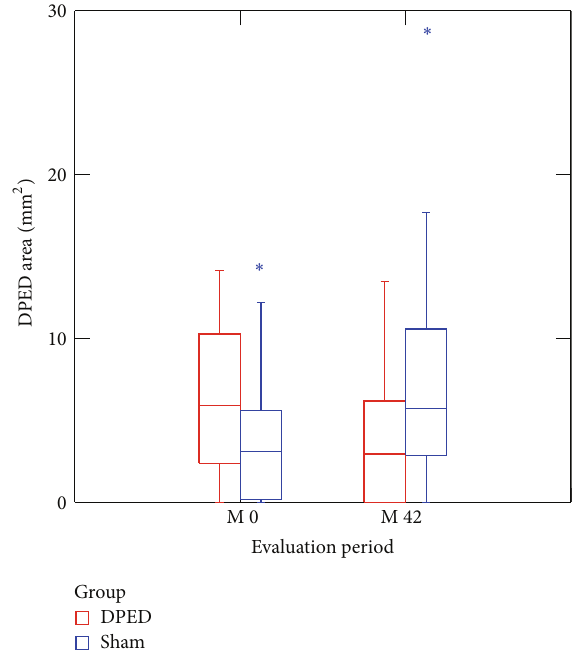
Figure 2: Changes in DPED areas between the two groups at the beginning and end of the follow up. The difference in DPED areas was statistically significant at the beginning and 3.5 years after the beginning of the follow up ( 𝑃 = 0.012 and 𝑃 = 0.015 , resp.).